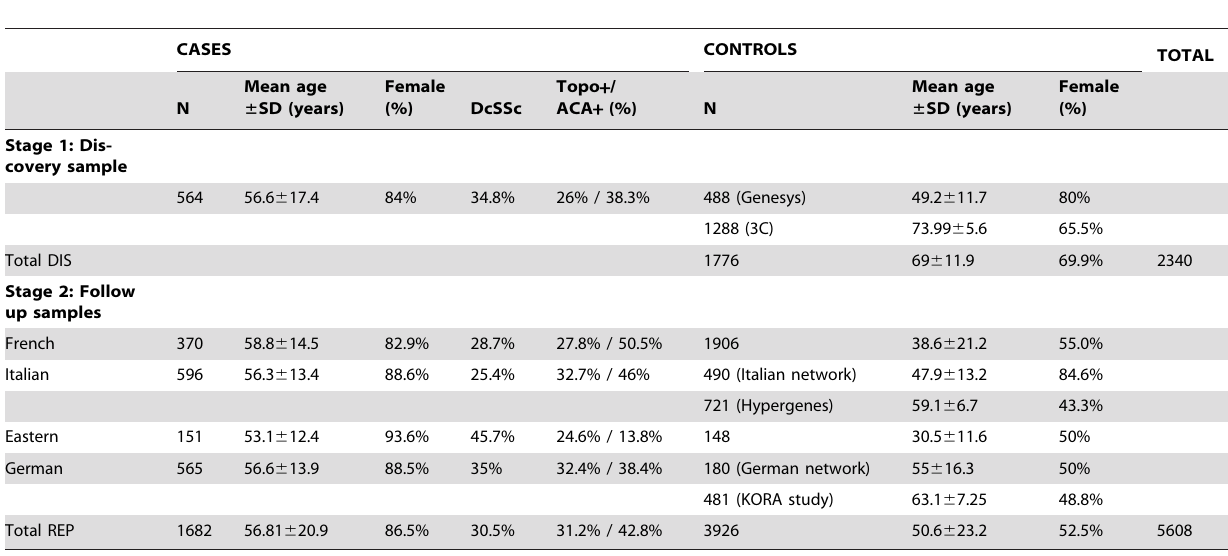
Table 1. Description of the study population (post quality control